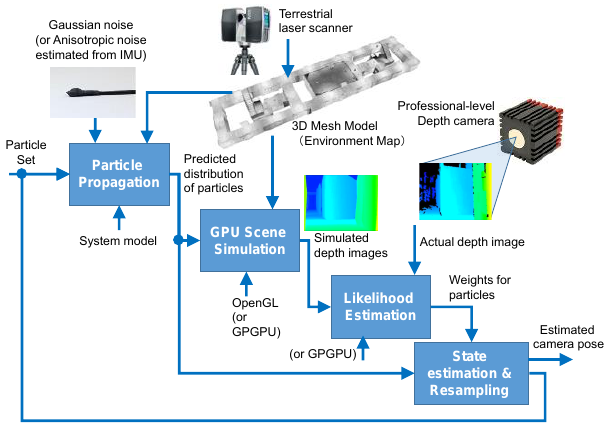
Figure 1. Our 3D MCL baseline